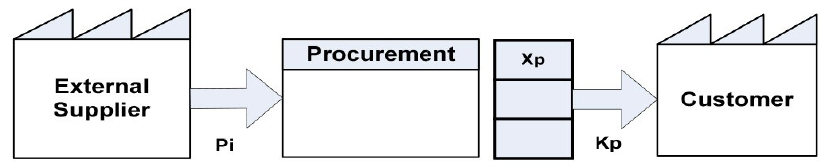
Figure 1. Variables and parameters in value stream